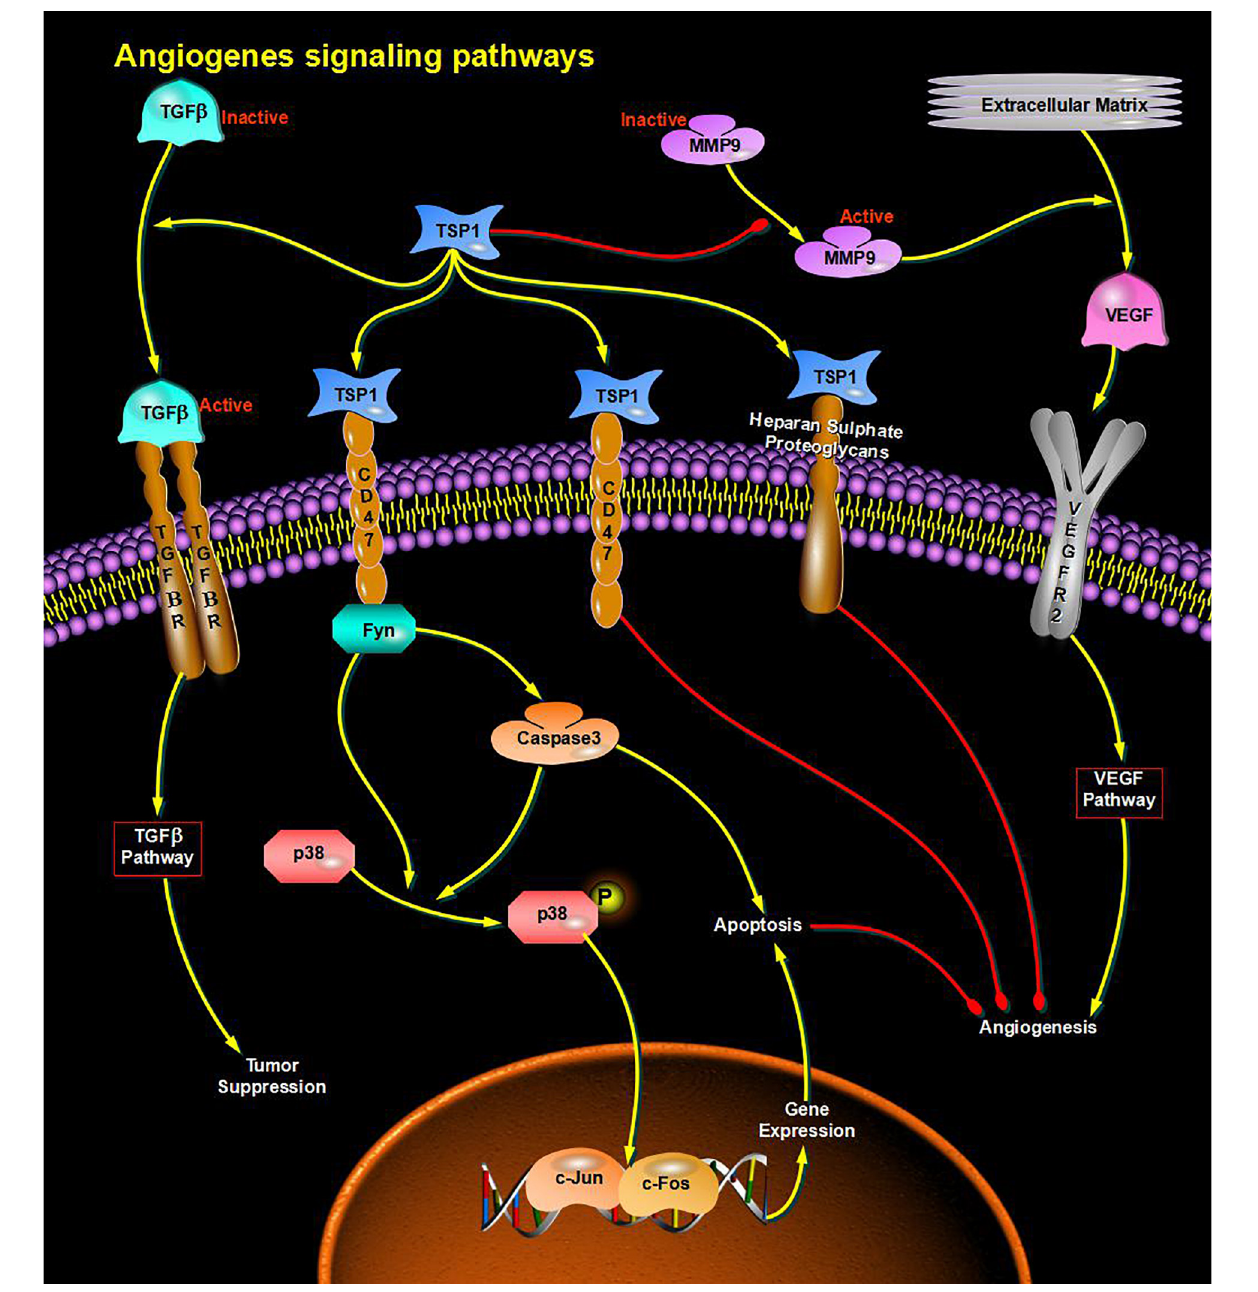
FIGURE 6 | miRNA regulates cell proliferation and apoptosis via the Angiogenesis signaling pathway and participates in angiogenesis in diabetes.